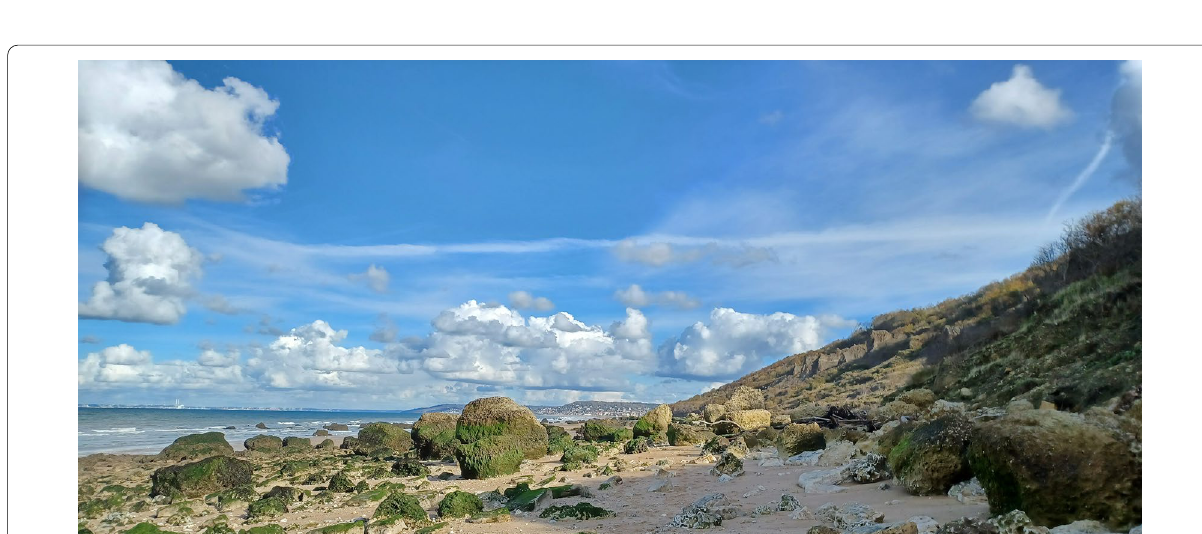
Fig. 1 Falaises des Vaches Noires, France, with the early Cenomanian blocks on the beach, where the here described Acesta clypeiformis (d’Orbigny, 1847) was found (photo by